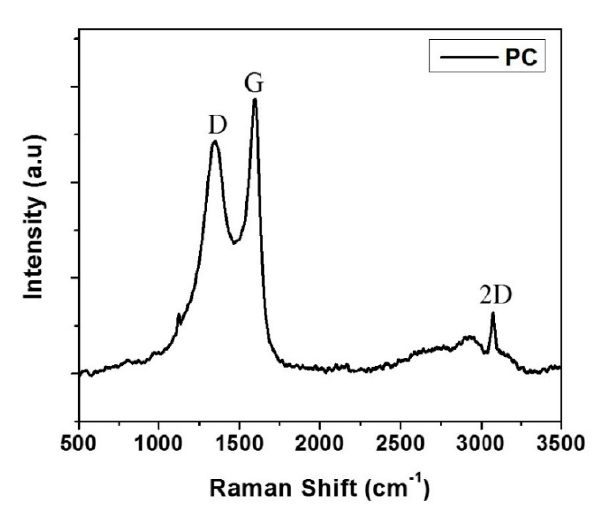
Figure 4: Raman spectroscopy of pyrolyzed coconut shell